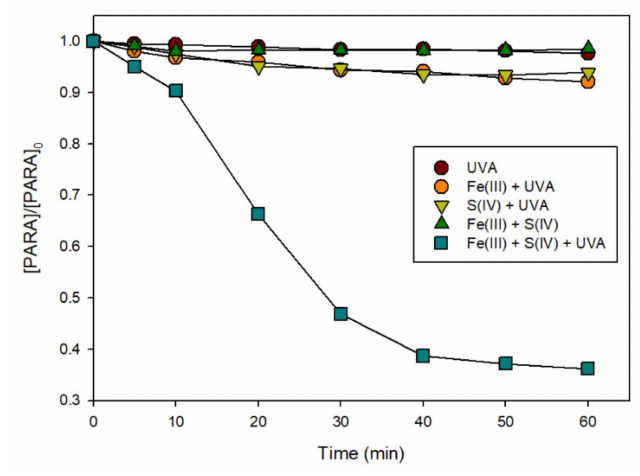
Figure 1. Degradation of PARA under various conditions in aerated solutions. Conditions: [PARA] 0 = 10 µ M, [Fe(III)] 0 = 0.1 mM, [S(IV)] 0 = 1.0 mM, pH init = 7.0.